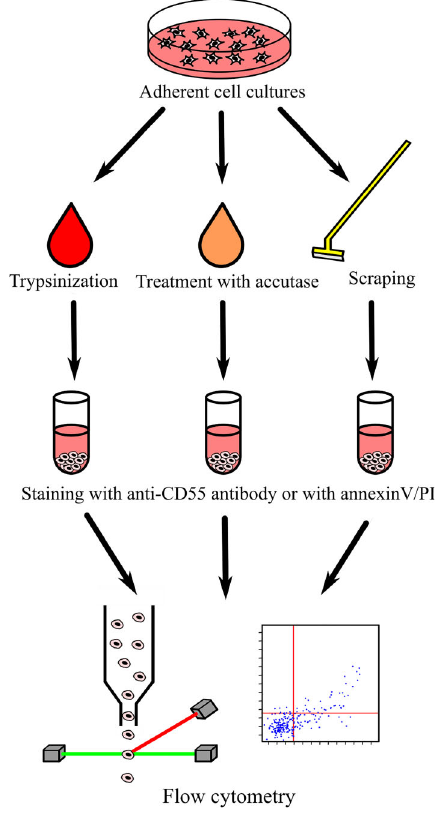
Figure 1. Schematic representation of the conducted experi-